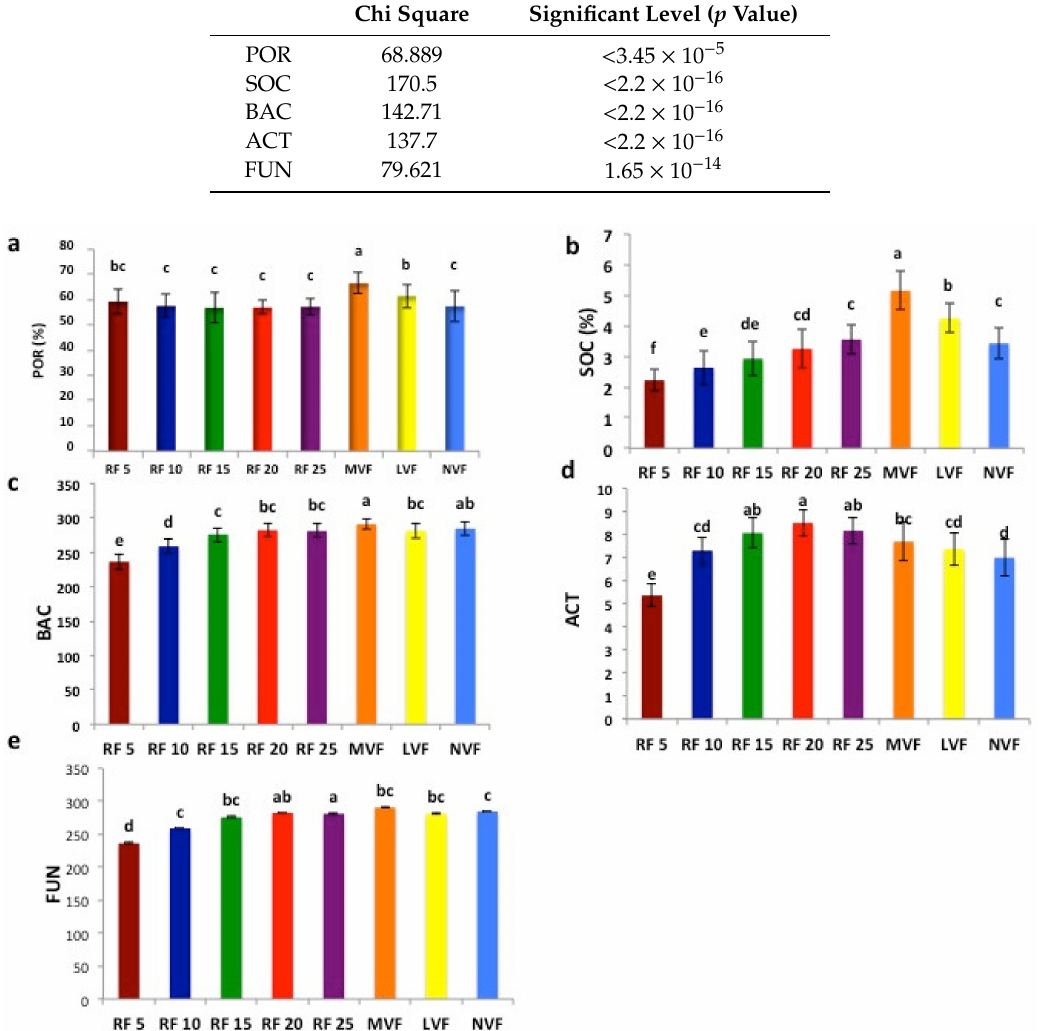
Figure 2. Mean values of key soil health parameters: ( a ). soil porosity (POR), ( b ). soil organic carbon (SOC), ( c ). bacterial counts (BAC), ( d ). fungi counts (FUN) and ( e ). actinomycete counts (ACT). Error bars represent the standard error of the mean (n = 27) for each vegetation type; rubber plantation chronosequence at 5-years-old (RF 5); 10-years-old (RF 10); 15-years-old (RF 15); 20-years-old (RF 20; 25-years-old (RF 25) and natural forests: Moderate volume (MVF); Low volume (LVF); very low forest (NVF)). Di ff erences are significant ( p < 0.05) when there are di ff erent letters above the